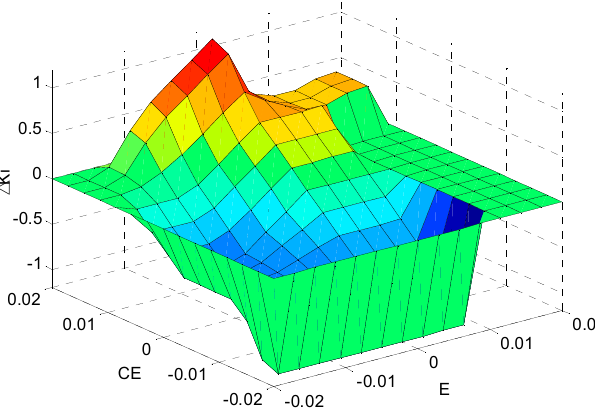
Figure 11. The output of the fuzzy inference system for ∆ K p .